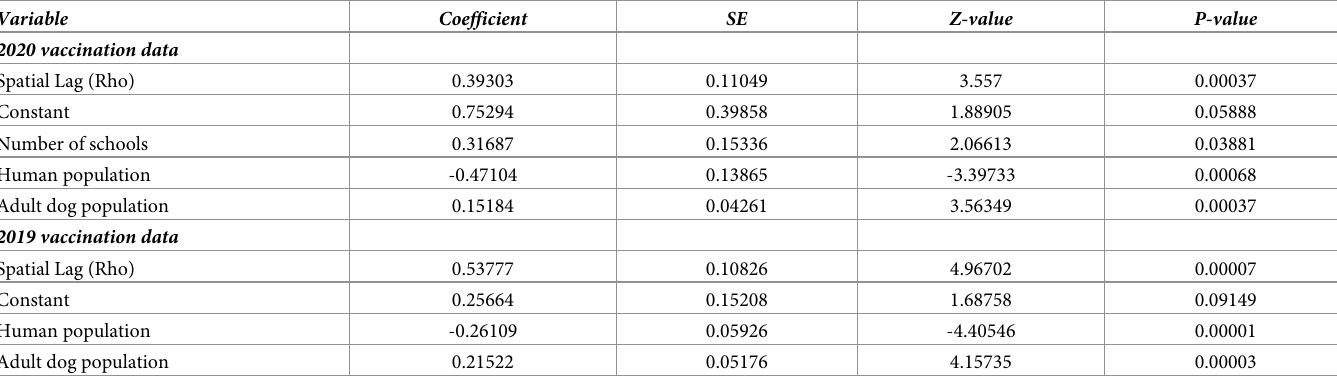
Table 2. The variables associated with a spatial lag model of log-transformed vaccination coverage against rabies in dogs in NCA regions, Namibia.